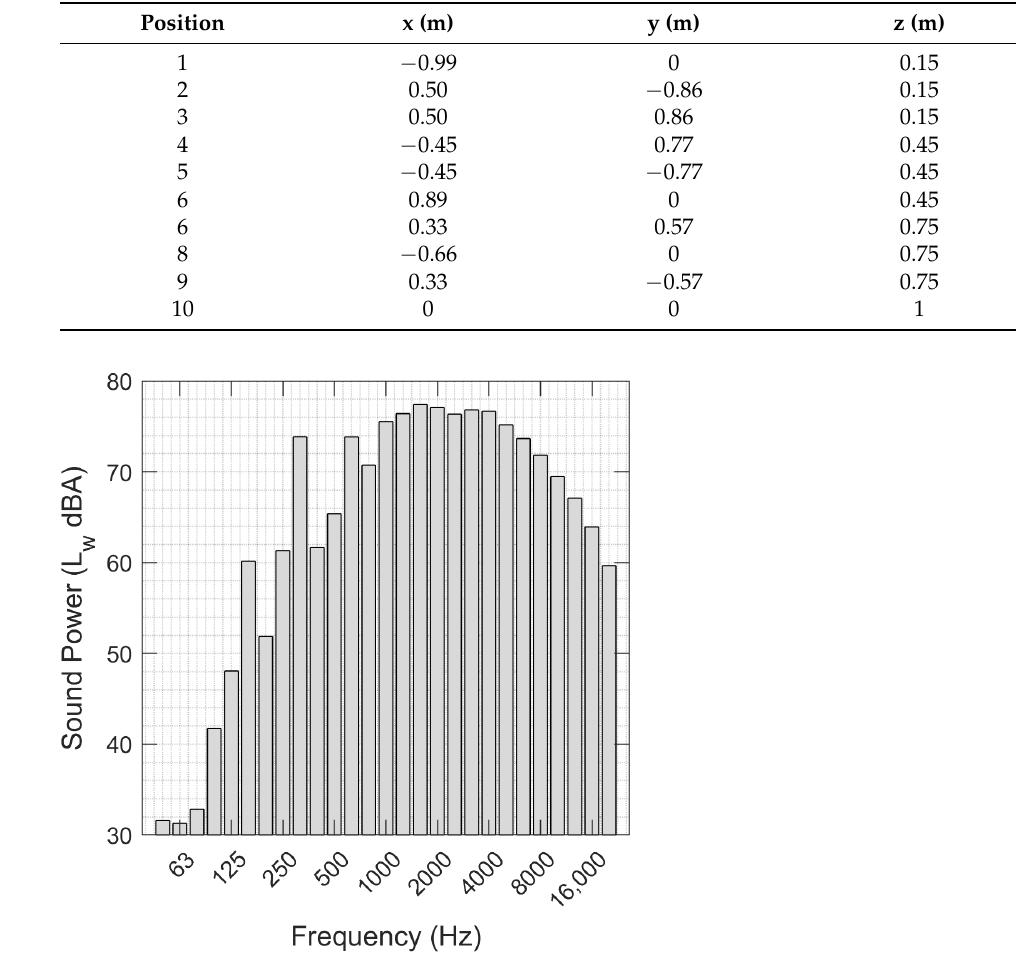
Figure 3. UAV Sound Power Measurement. Table 2. UAV Sound Power